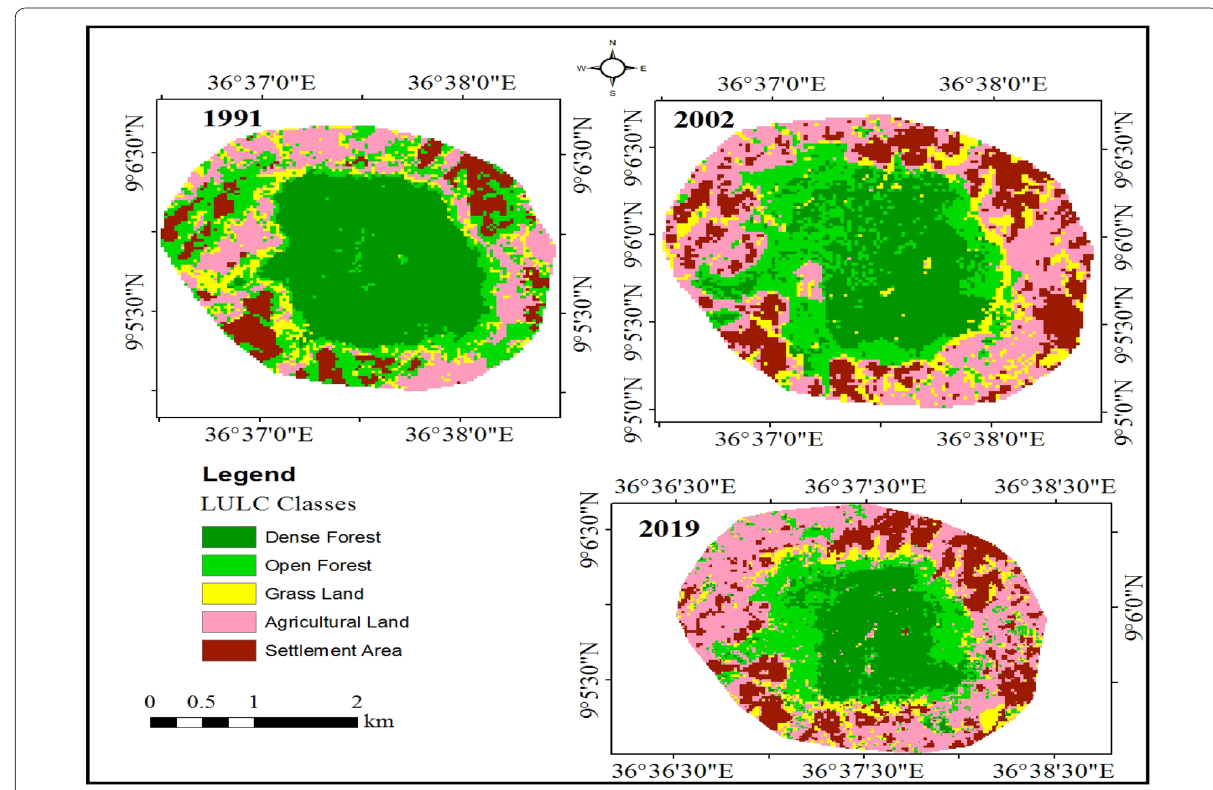
Fig. 3 Land use land cover map of 1991, 2002 and 2019